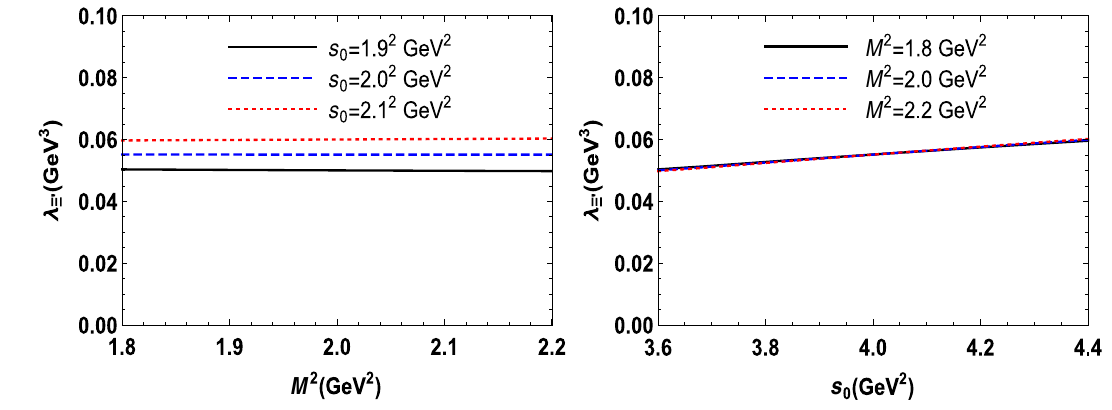
Fig. 4 The same as in Fig. 2, but for the radially excited (cid:2) (cid:3) baryon with β = 0 . 7